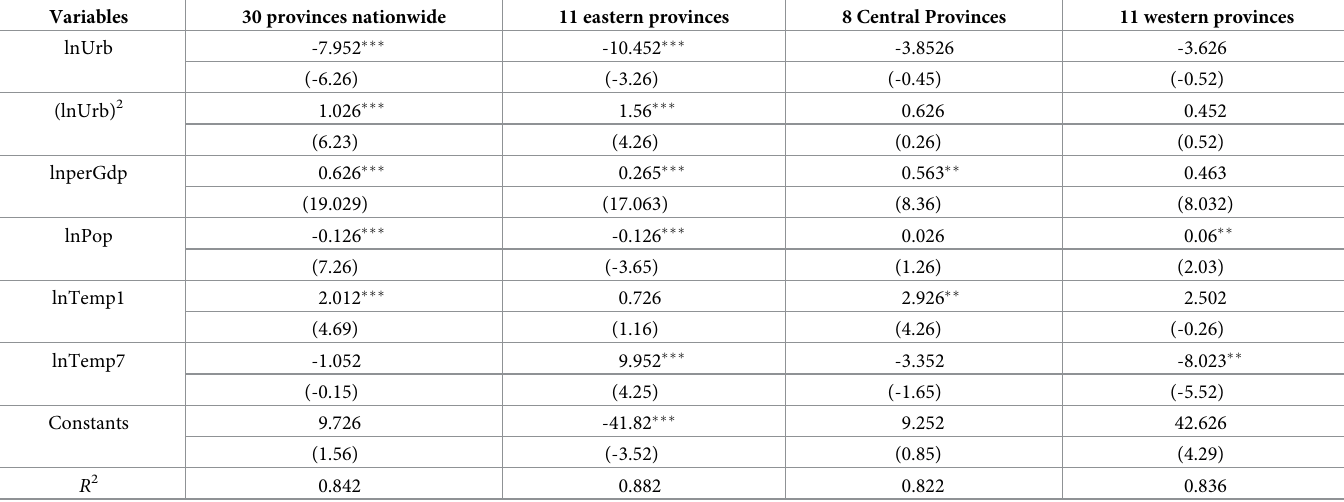
Table 9. GMM estimation results of the residential complete energy consumption